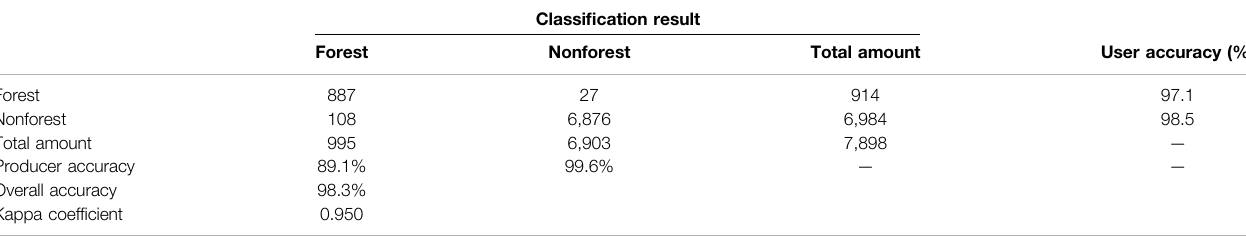
TABLE 3 | Confusion matrix of the RF forest cover map.